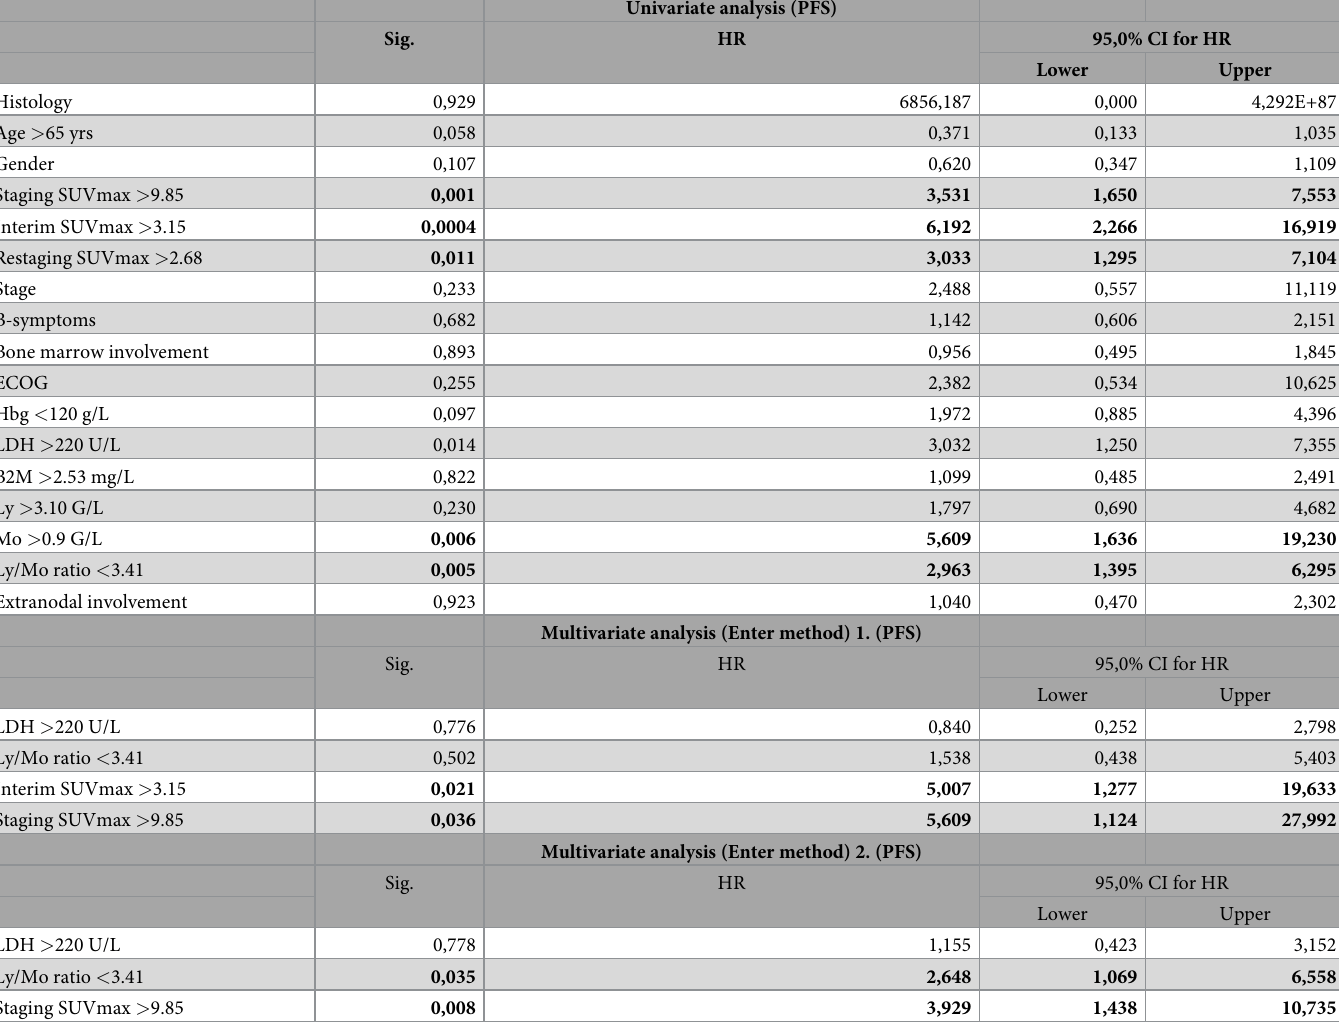
Table 2. Univariate and multivariate analysis of prognostic factors that could possibly affect survival of follicular lymphoma patinets’. Univariate analysis (PFS)